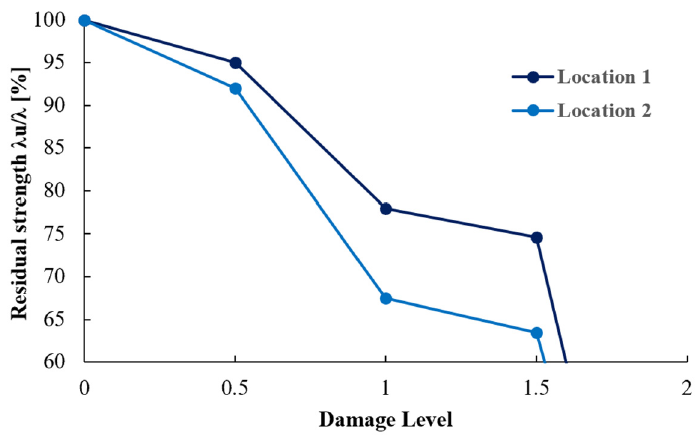
Figure 14. Robustness curves for 2D RC frame structure for location 1 and location 2.